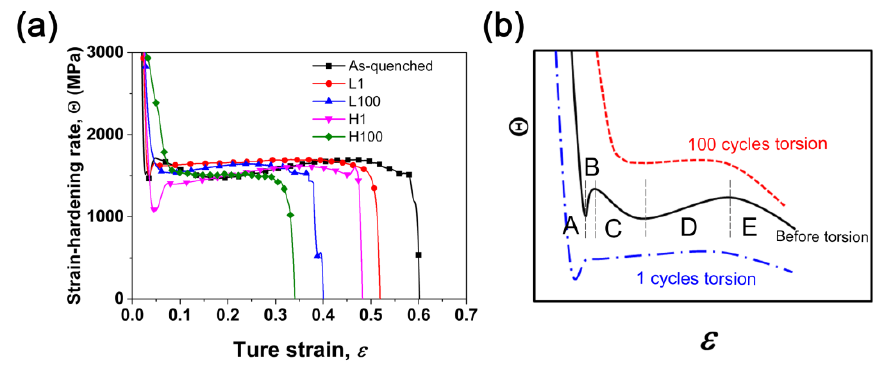
Figure 7. Strain-hardening response of various samples: ( a ) experimental data; ( b ) schematic diagram showing typical strain-hardening curves of FCC materials with low stacking fault energy. The strain-hardening rate Θ is calculated as Θ = d σ / d ε .